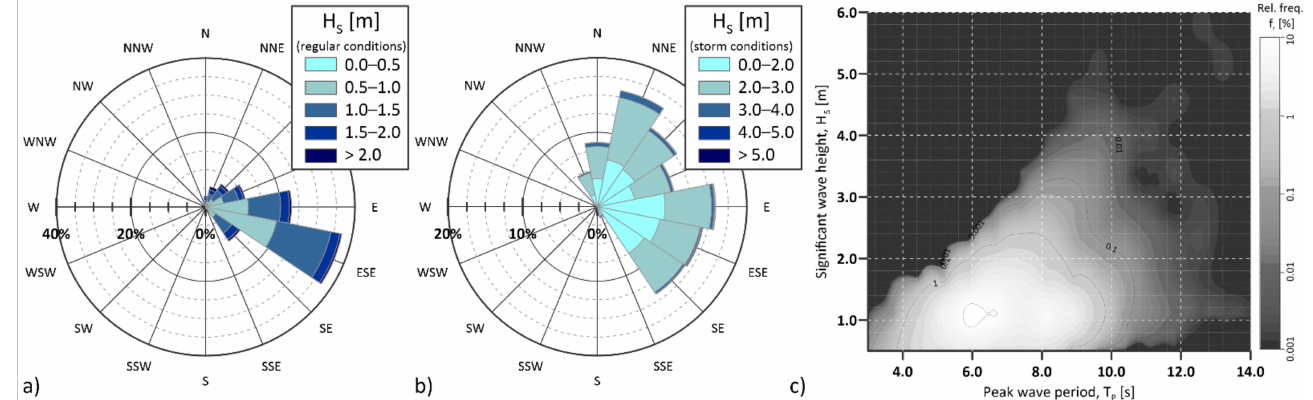
Figure 4. Wave rose diagrams for incident waves in ( a ) prevailing and ( b ) extreme conditions. ( c ) Bivariate histogram of H S and T P for wave climate conditions from ERA5 at 21.0 ◦ N, 86.5 ◦ W. For extreme wave conditions, the critical wave height threshold was h cri t = 1.71